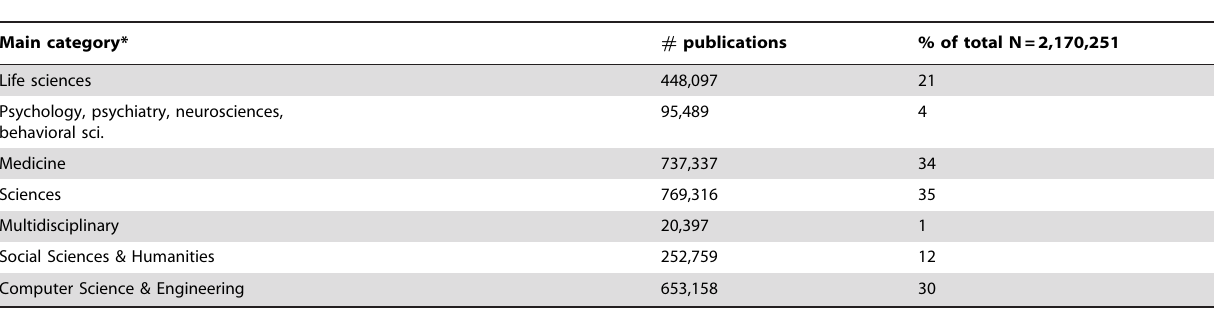
Table 2. Distributions of items published in 2010 and indexed by Scopus.